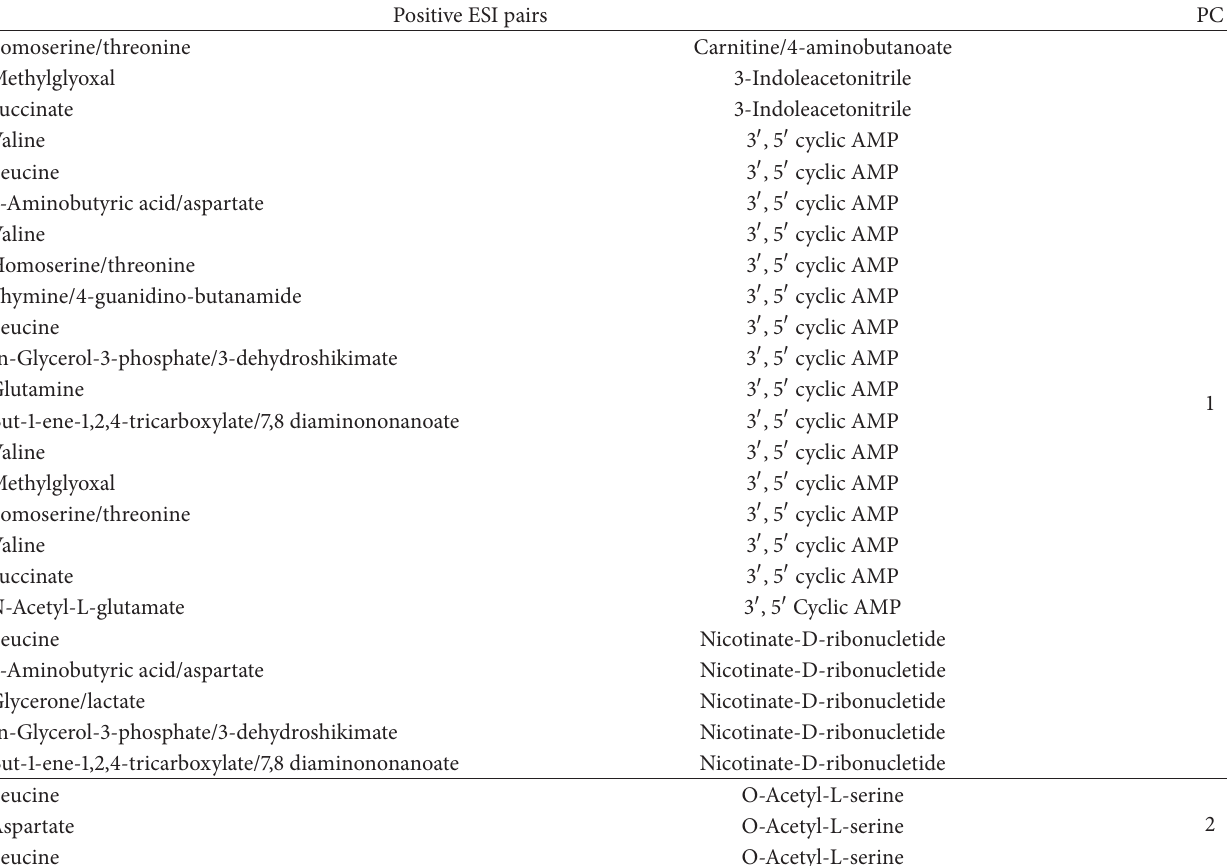
Table 3: List of major metabolites (significantly correlate response over time in the different C-source) by positive ESI